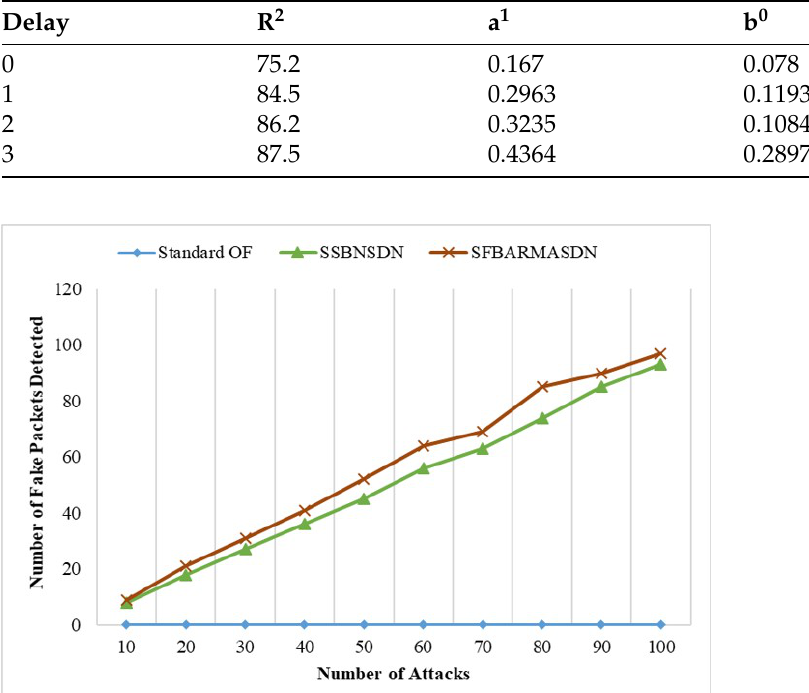
Figure 8. Comparison of the fake packets detected for the standard OpenFlow, SSBN SDN , and SFBARMA SDN